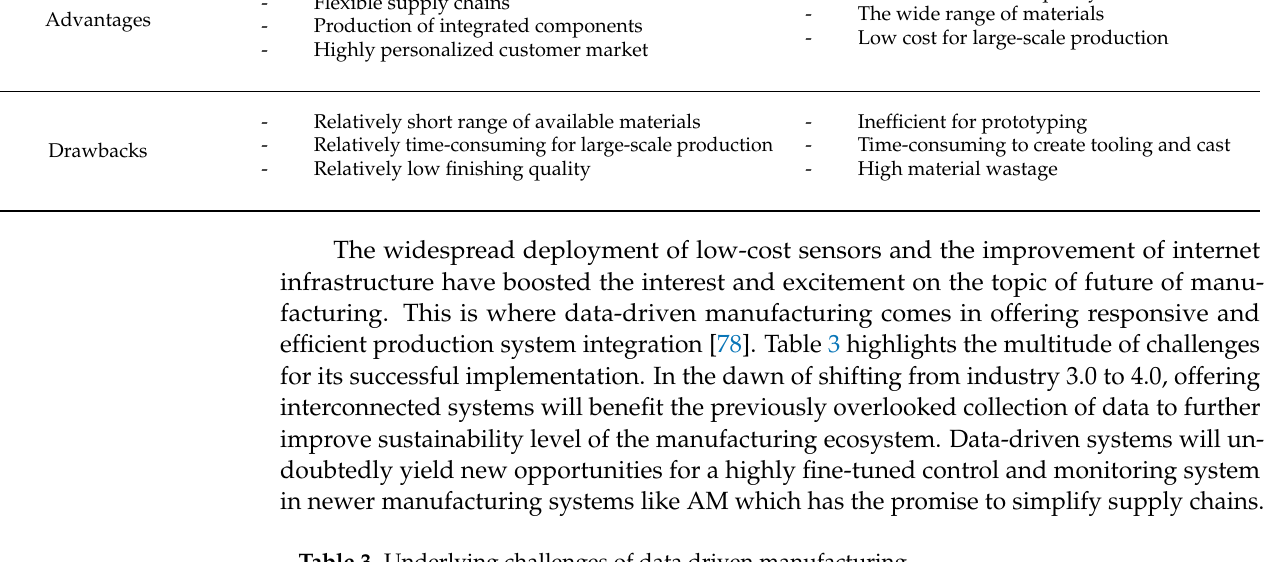
Table 3. Underlying challenges of data driven